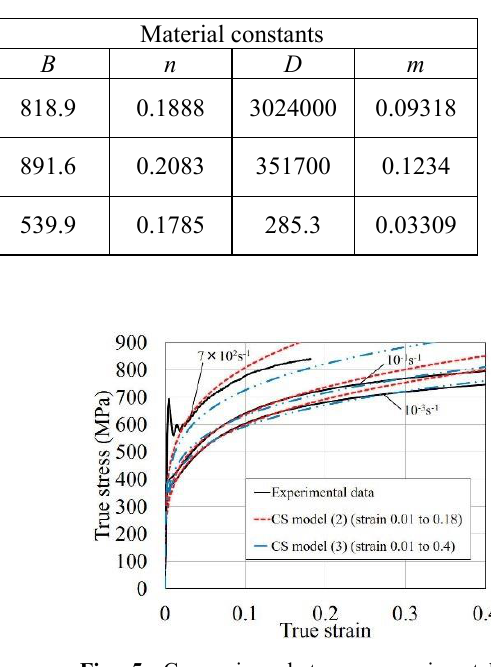
Table 1. Material constants of CS model.